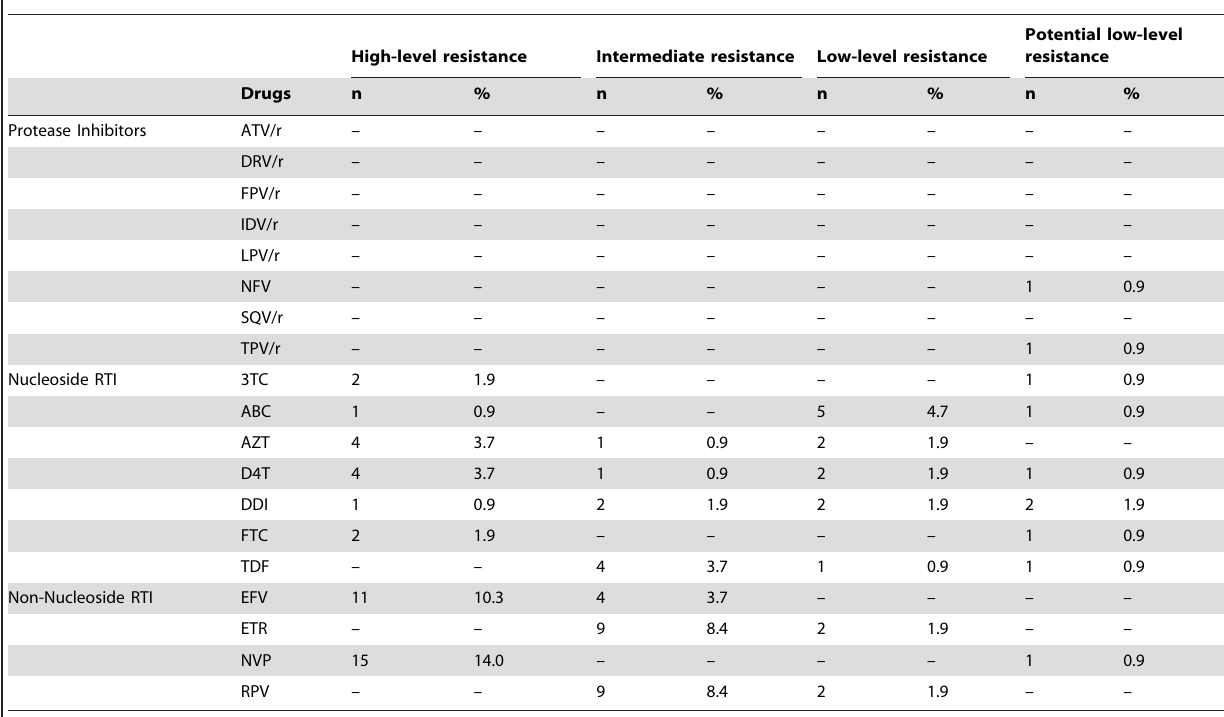
Table 5. Natural resistance rate of HIV-1 in Henan former paid blood donation